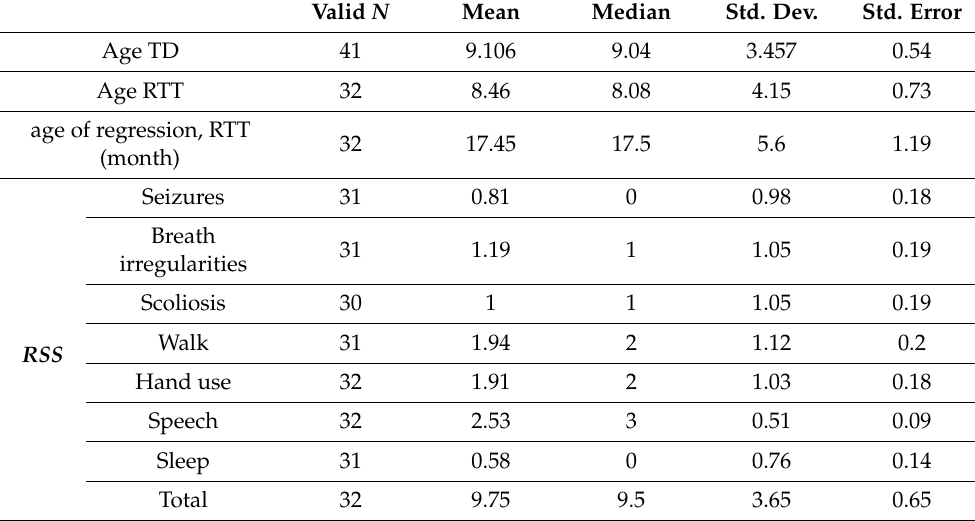
Table 3. Descriptive statistics of demographic and medical RTT and TD groups. RSS scores are presented only for patients (0—no deficit, 3—severely affected with exact characteristics specific to particular subscale).